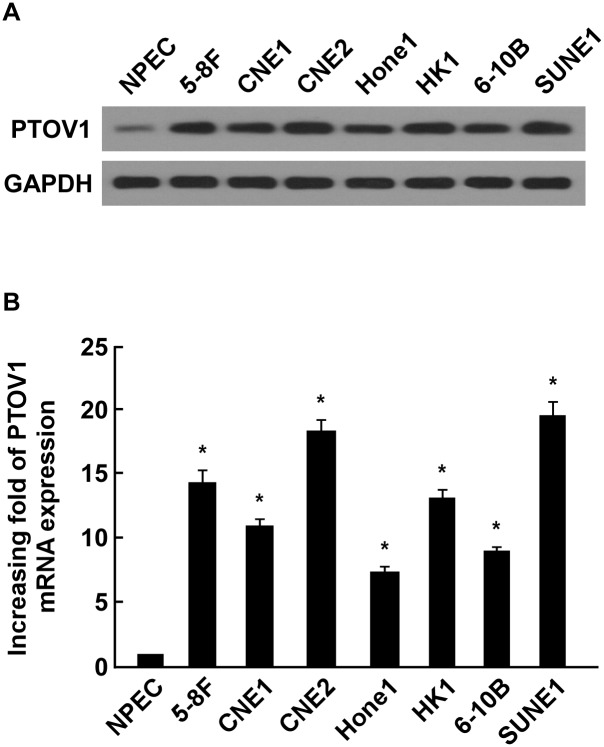
Overexpression of PTOV1 protein and mRNA in NPC cell lines.(A and B) Expression of PTOV1 protein and mRNA in NPC cell lines (5-8F, CNE1, CNE2, Hone1, HK1, 6-10B and SUNE1) and NPEC were examined by western blotting (A) and real-time PCR (B). Expression levels were normalized to GAPDH. Error bars represent the standard deviation of the mean (SD), calculated from three parallel experiments. * P < 0.05.